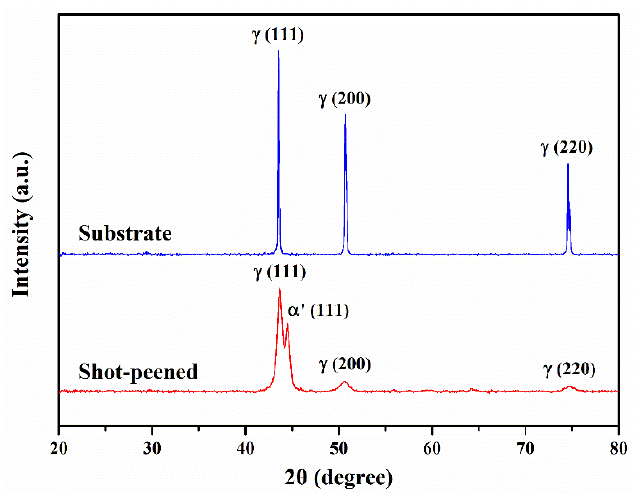
Figure 3. X-ray diffraction (XRD) patterns of the substrate and shot-peened sample.